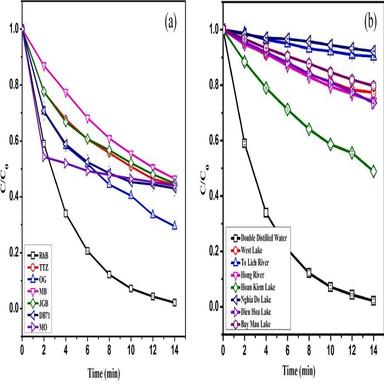
The ability of NiCoFe-LDO and PMS to decompose (a) different dyes in water and (b) RhB dye in different types of natural surface water. (Condition: 20 mgdye/ L, 500 mgPMS/L, 60 mgLDO/L, pH 7.0, 25 ◦C).